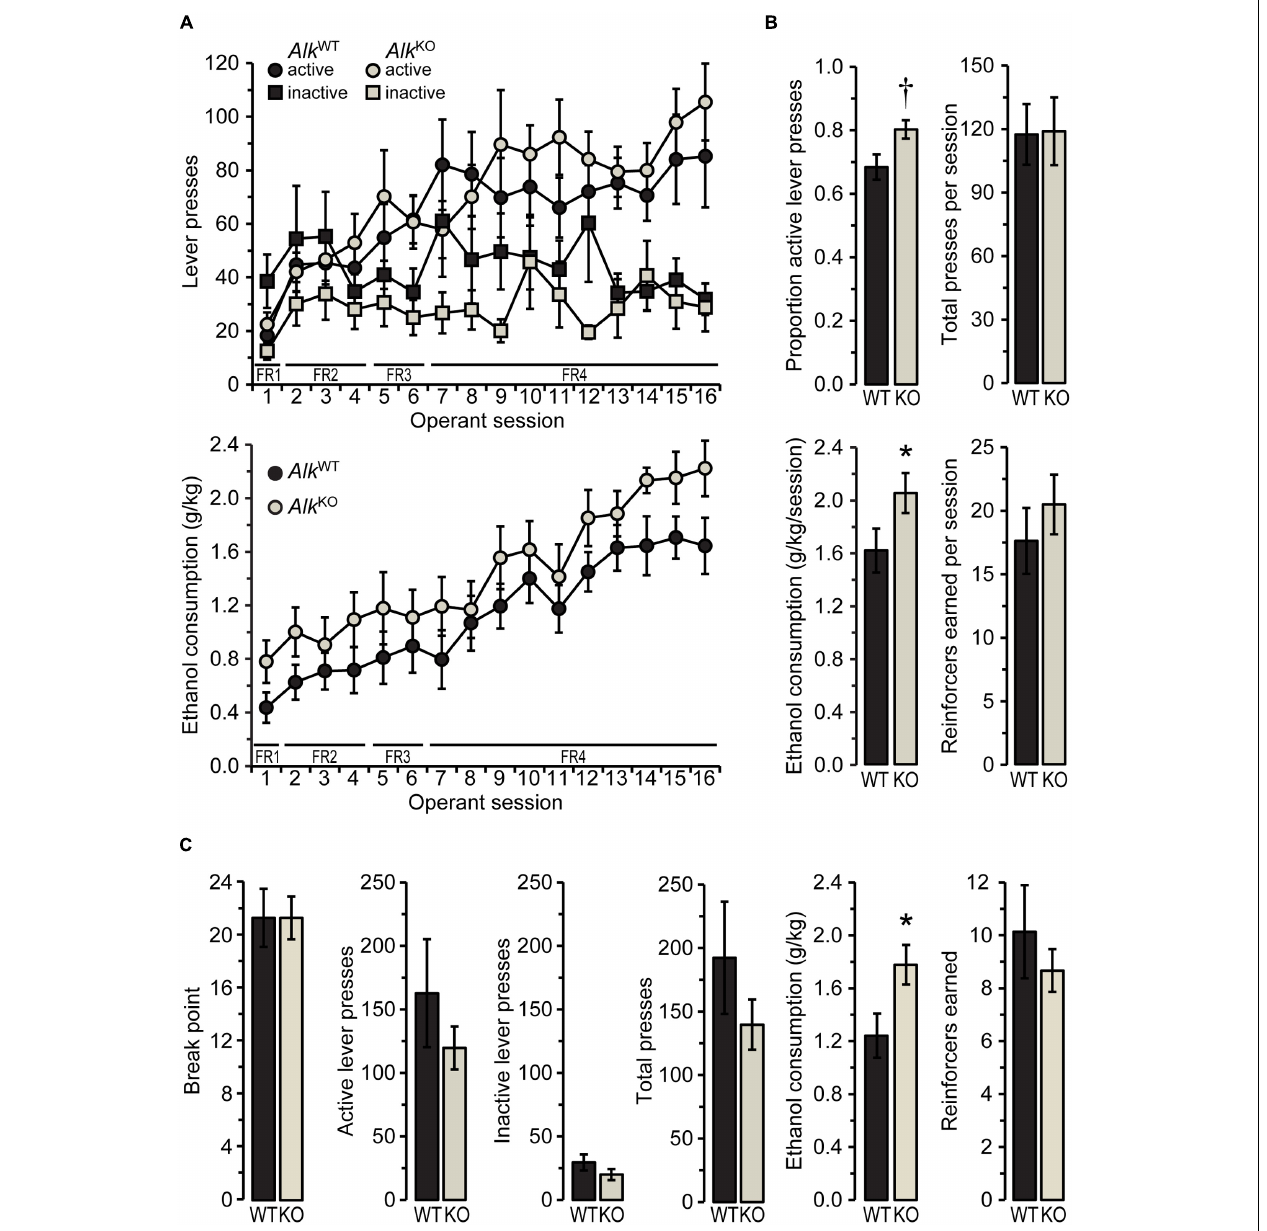
FIGURE 1 | Alk KO mice drink more ethanol than Alk WT during operant self-administration sessions. (A) Active and inactive lever presses (top) and ethanol consumption (bottom) during all 1-h operant sessions with fixed ratio (FR) schedules of reinforcement (required ratio for each session is indicated along x-axis). (B) Values shown are averages of the final five FR4 sessions. † p = 0.07, ∗ p = 0.047, Alk KO vs. Alk WT . (C) Lever pressing and reinforcement during the progressive ratio (PR) test. ∗ p = 0.02, Alk KO vs. Alk WT . All data shown as group means ± SEM; n = 15 for each genotype.